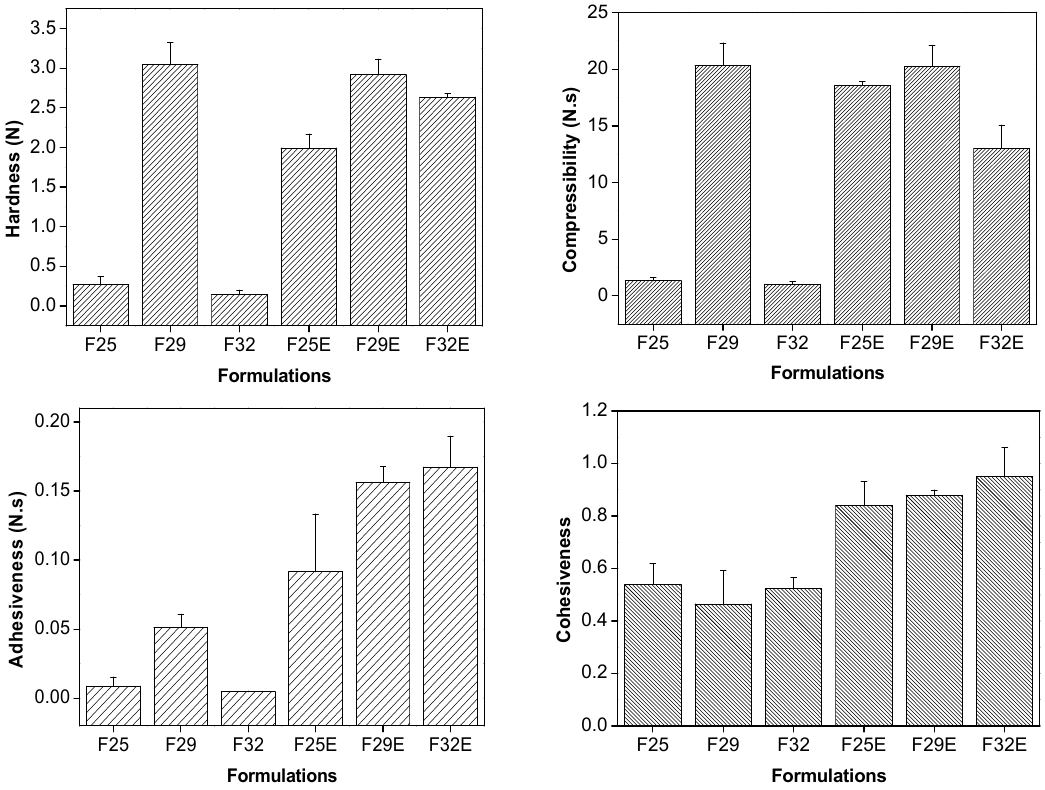
Figure 5. Mechanical properties (hardness, compressibility, adhesiveness, cohesiveness) of unloaded and extract loaded formulations. The data were collected at 25 ± 0.5 °C.